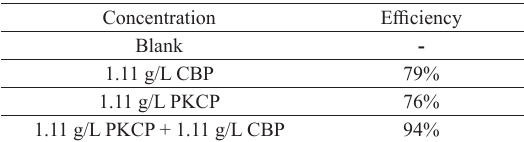
Figure 9. Cathodic polarization curves obtained for the ASTM 1020 carbon steel in a 0.5 mol.L -1 HCl solution with various CBP and PKCP concentrations. Table 3. Gravimetric results of ASTM 1020 carbon steel after 120 min of immersion in a 0,5 mol.L -1 HCl solution without and with different inhibitor